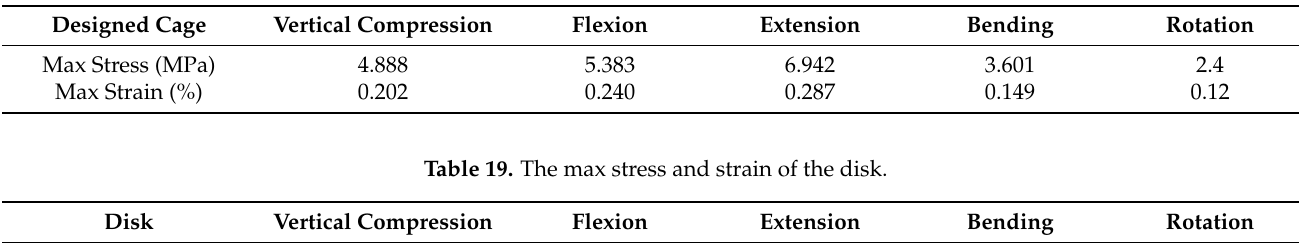
Table 18. The max stress and strain of the designed cage.